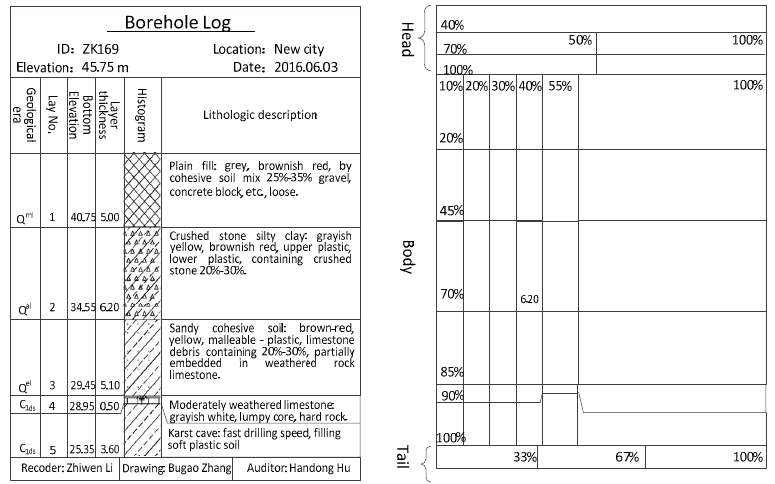
Figure 2. The structure of a borehole log.